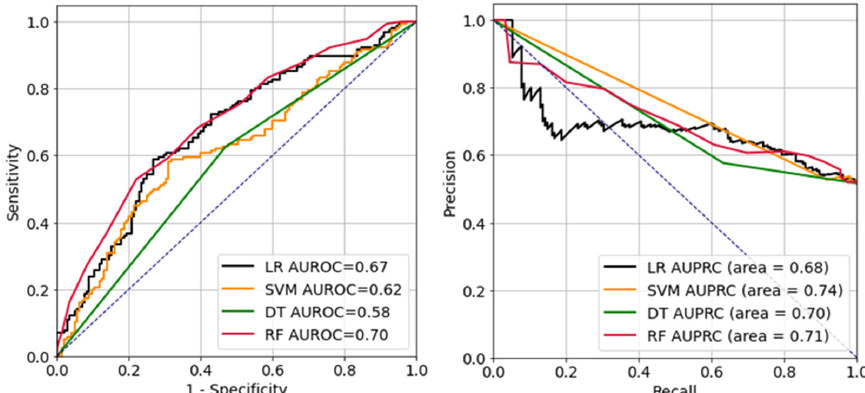
Figure 2. Receiver operating characteristic curve ( left ) and precision-recall curve ( right ). LR, logistic